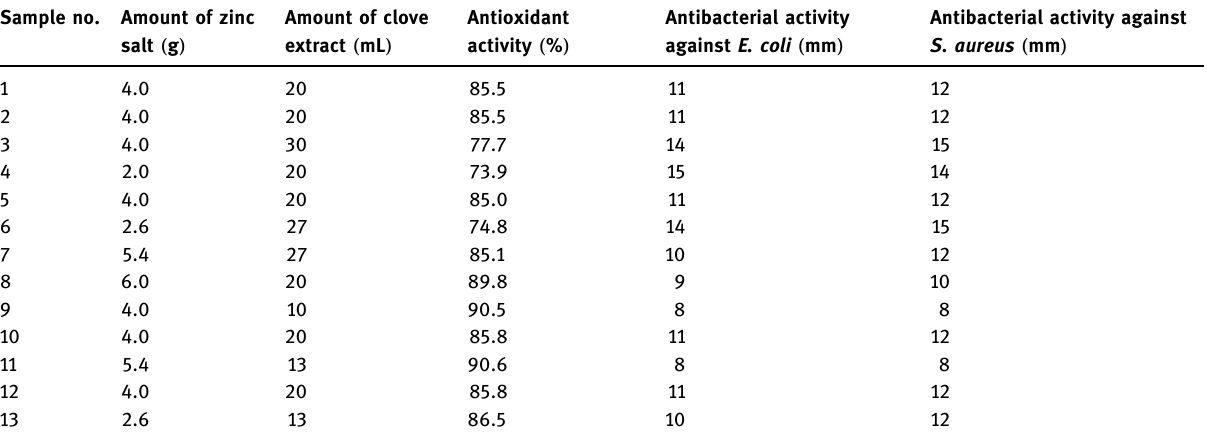
Table 1: CCD, independent variables ’ levels and experimental values for the response variables Sample no. Amount of